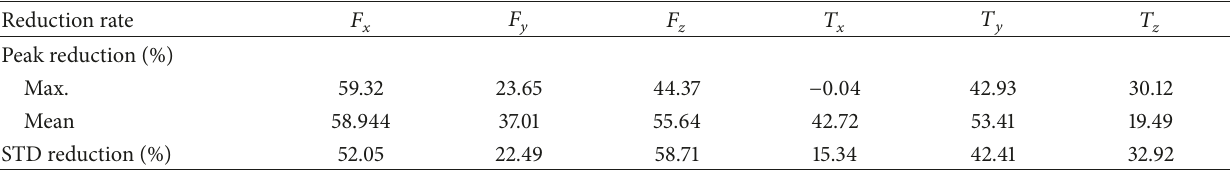
Table 1: Total disturbance reduction ratio, with and without